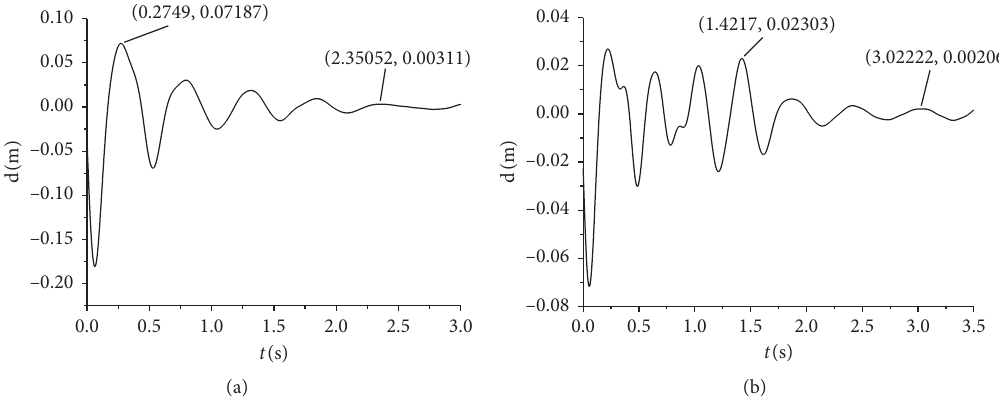
Figure 7: Displacement time-history curves of spring-cylinder isolation device. (a) TQGG1. (b) TQGG2.